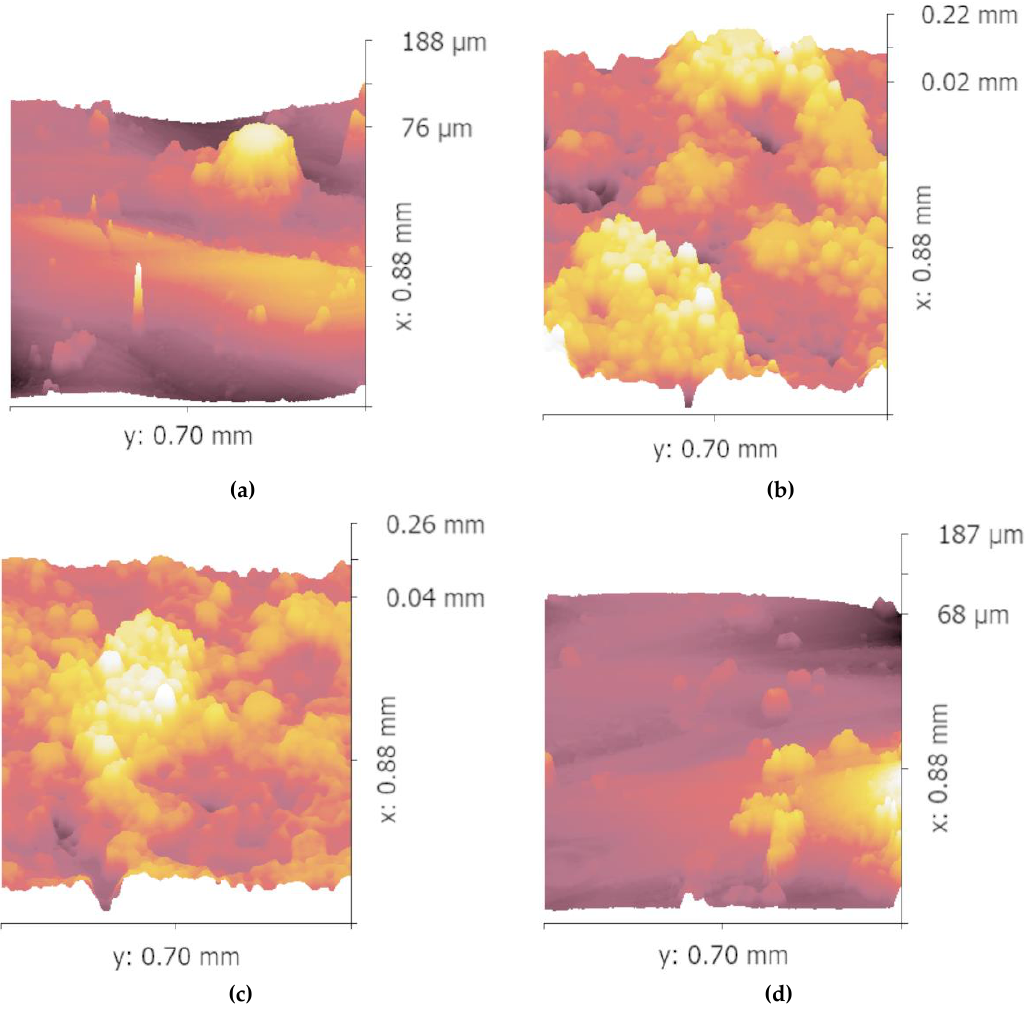
Figure 8. Micro-topography images on the edge of the inner structure of the first part printed by the first scanning strategy ( a ), second part printed by the first scanning strategy ( b ), first part printed by the second scanning strategy ( c ), and second part printed by the second scanning strategy ( d ), respectively.